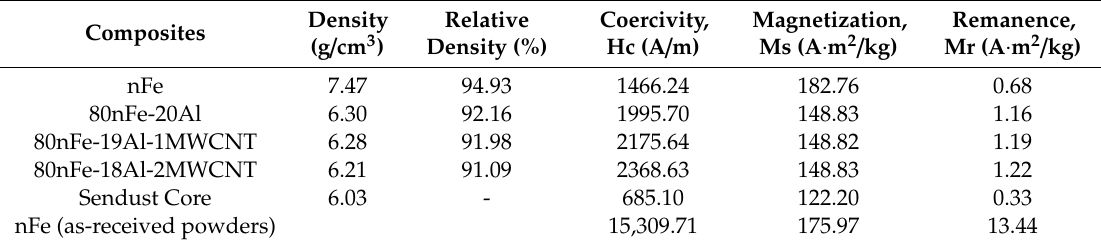
Figure 6. Hysteresis loops according to the MWCNT content; ( a ) full loops; ( b ) magnification of the selected region in ( a ); ( c ) the as-received iron nanoparticles. Table 2. Magnetic properties and density of the composites according to the MWCNT